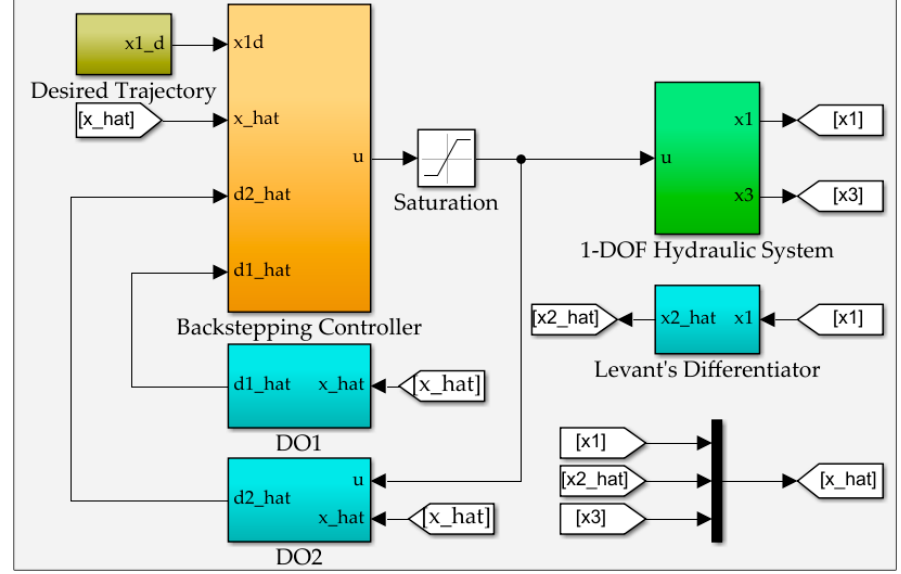
Figure 3. Control design in MATLAB/Simulink environment.